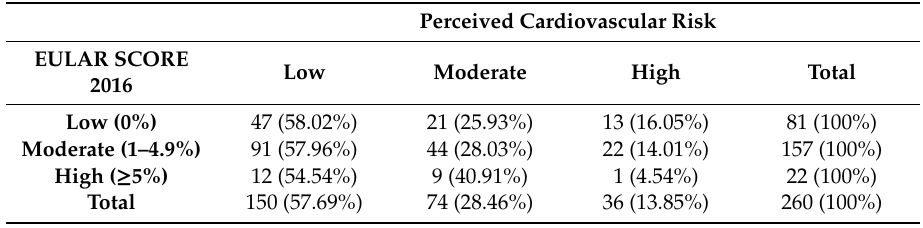
Table 2. Relationship between perceived cardiovascular risk and European League Against Rheumatism (EULAR) Systematic Coronary Risk Evaluation (SCORE)-estimated cardiovascular risk.